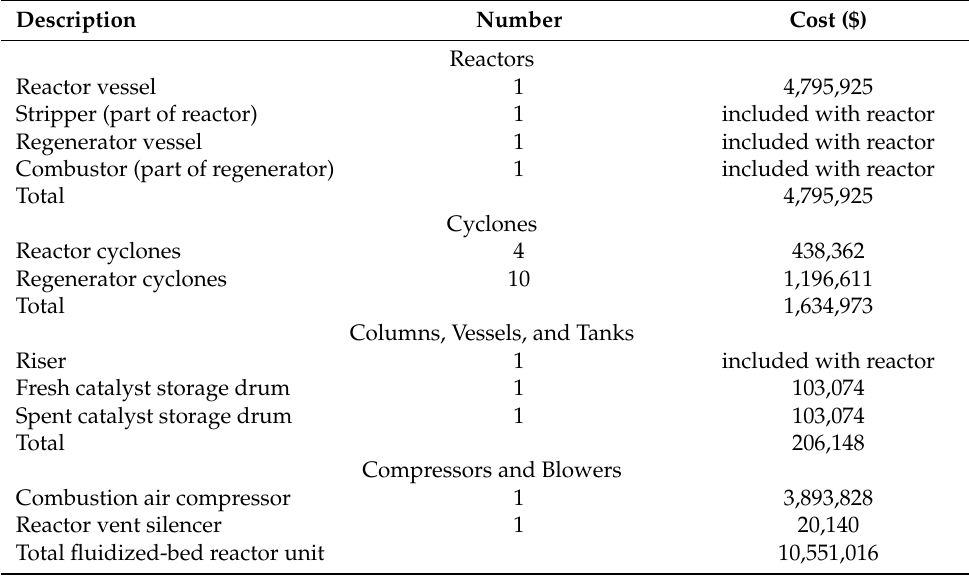
Table 6. Fluidized-bed reactor unit equipment